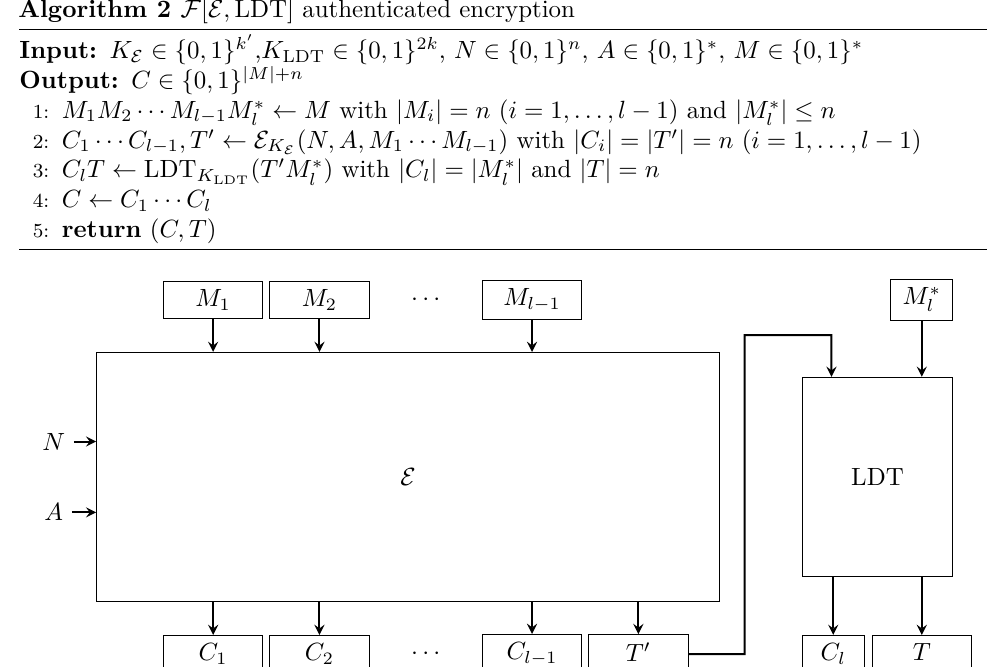
Algorithm 2 F [ E , LDT] authenticated encryption